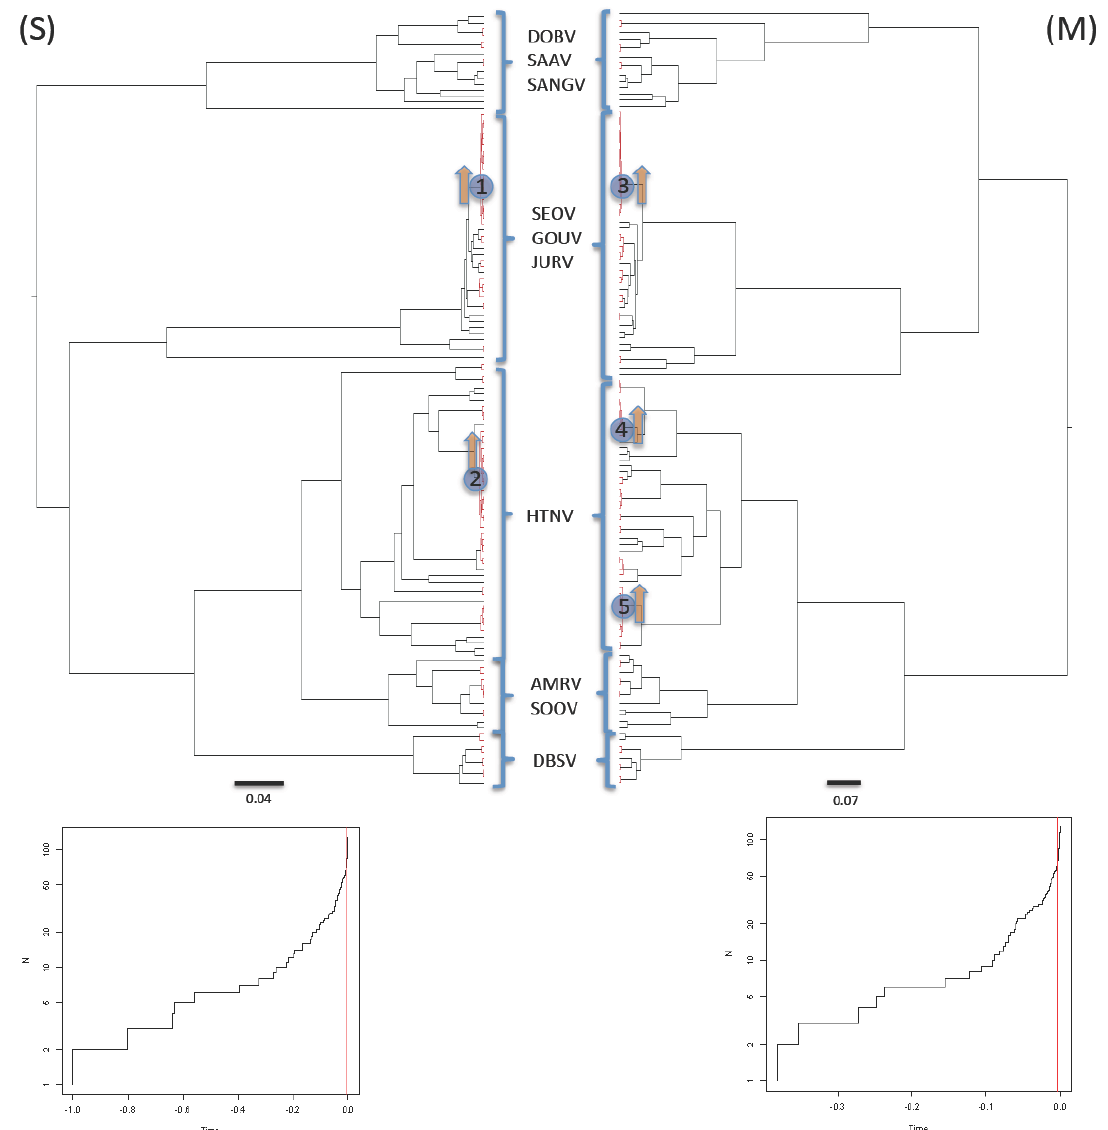
Figure 2. M and S segments of murine-associated hantaviruses BEAST time calibrated (ultrametric) trees. Root age was arbitrarily assigned to 1. A Generalized mixed Yule coalescent (GMYC) model was used to determine thresholds such that nodes before the threshold are considered as species diversification events, whereas branches crossing the thresholds define clusters following a coalescent process (in red). Shifts in diversification rates determined using MEDUSA algorithm are represented by numbered blue circles. Increases in lineage diversification rates among the tree compared to the reminder tree determined by the PRC Parametric Rate Comparison) test implemented in the iterates package are represented by orange arrows. Inserts illustrate the Lineage-through-time (LTT) plots based on the BEAST time calibrated (ultrametric) trees for the M and S segment of murine-associated hantaviruses in which the occurrence and the position of the switch between two evolution patterns (red line) was determined by the method of Pons et al. implemented in the package SPLITS